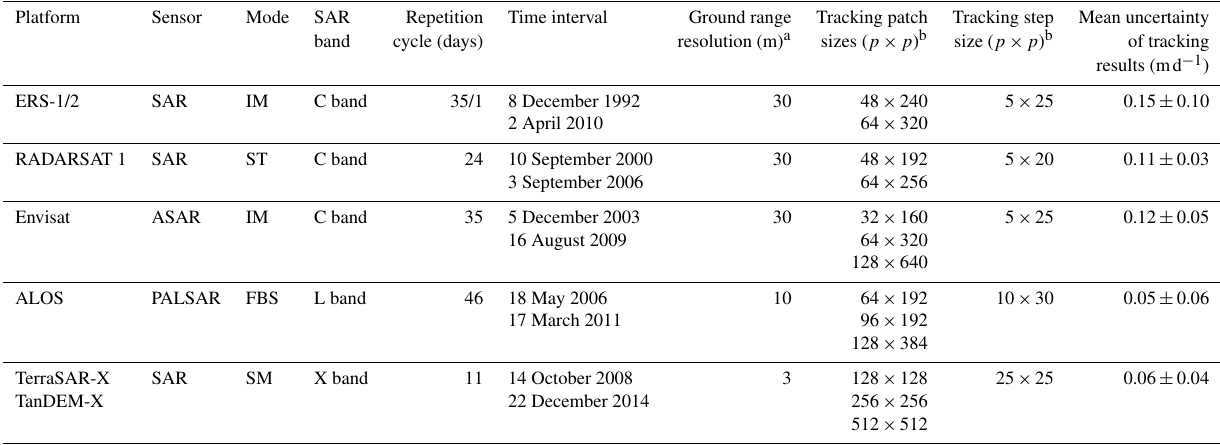
Table 2. Overview of SAR sensors and specifications used in this study.